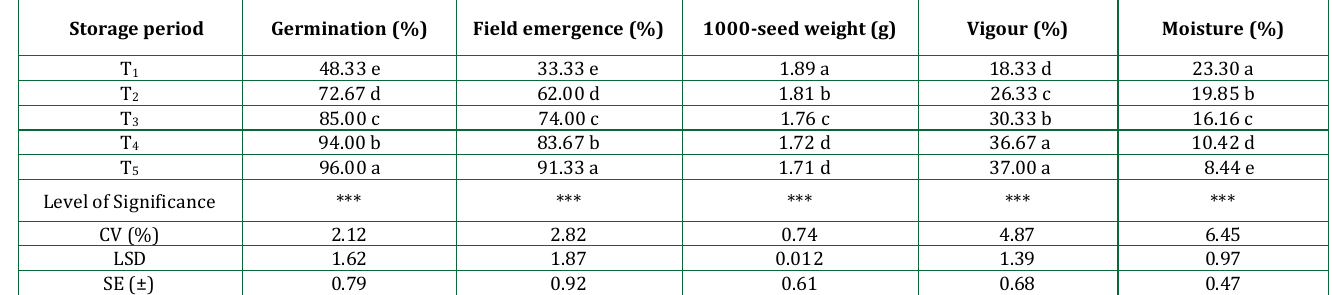
Table 1: Effect of storage period on tossa jute ( Corchorus olitorius ) seed